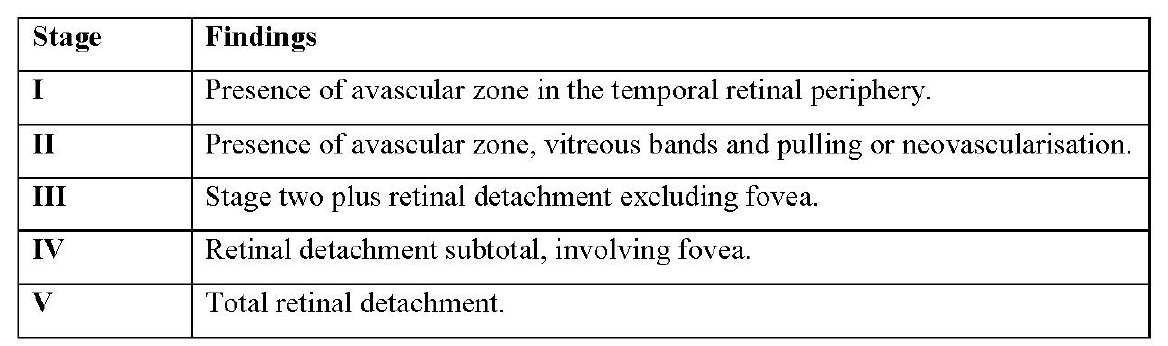
Table 1: Showing the different stages of FEVR. This patient showed all signs of the